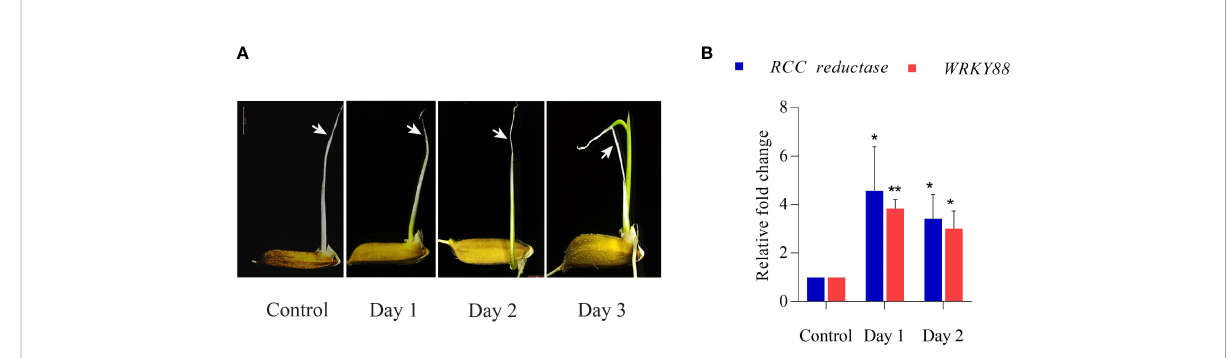
FIGURE 1 Coleoptile senescence in rice. (A) Different stages of coleoptile senescence in rice seedlings after transfer from anaerobic (submergence) to aerobic conditions. (B) Expression pro fi le of senescence associated genes ( SAGs) at different stages of coleoptile senescence using quantitative PCR. For normalization eEF-1 a was used as an internal control. Three biological replicates and two technical replicates were included in the study. White arrows highlight the progression of senescence in the coleoptile. Asterisks indicate a signi fi cant difference between the control and senescence tissues (Student ’ s t -test, * P < 0.05, ** P < 0.01). RCC reductase: red chlorophyll catabolite reductase